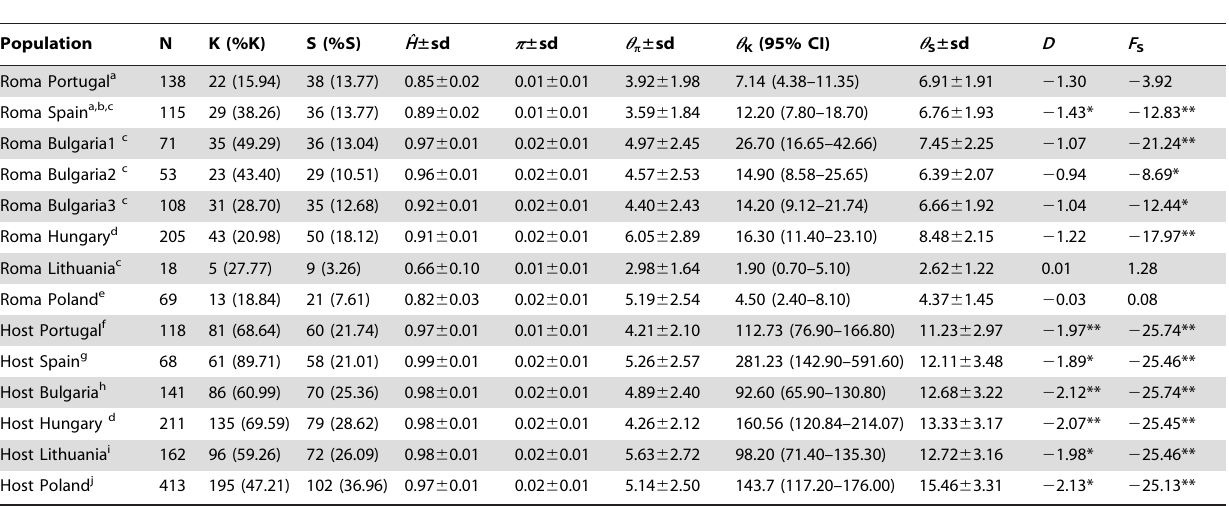
Table 1. Sequence diversity indices for mtDNA lineages (positions 16,090–16,365) in the Roma populations and corresponding host populations included in the present